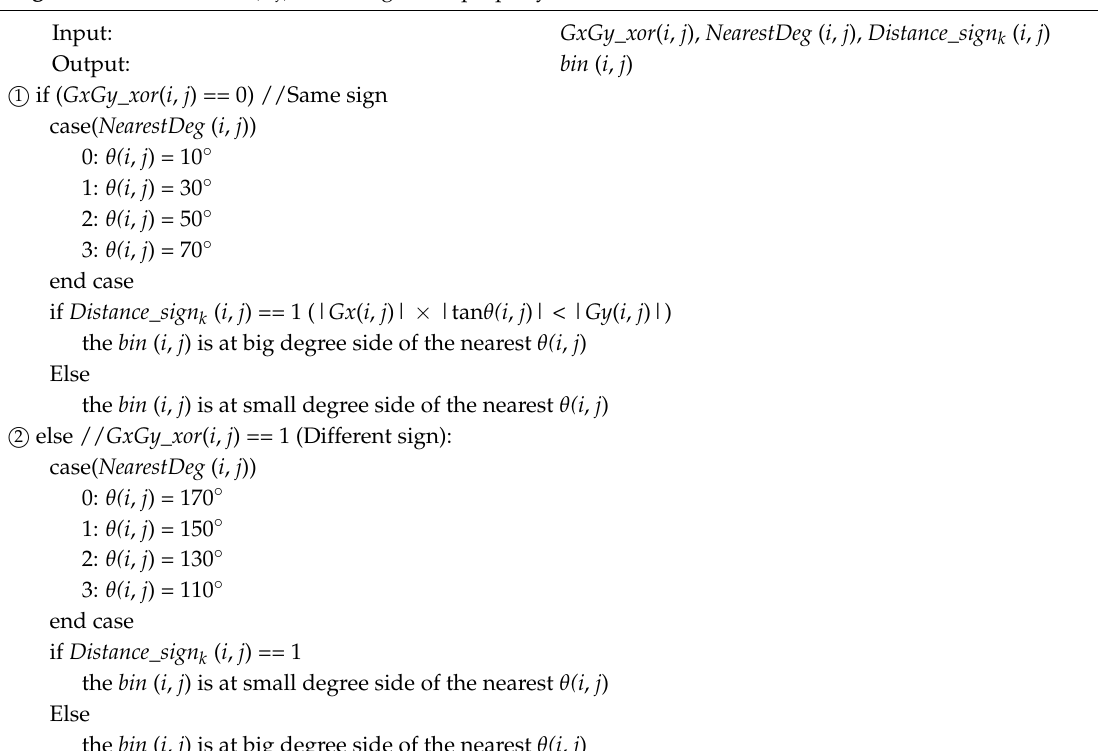
Algorithm 3. Obtain bin ( i , j ) according to the property of tan θ